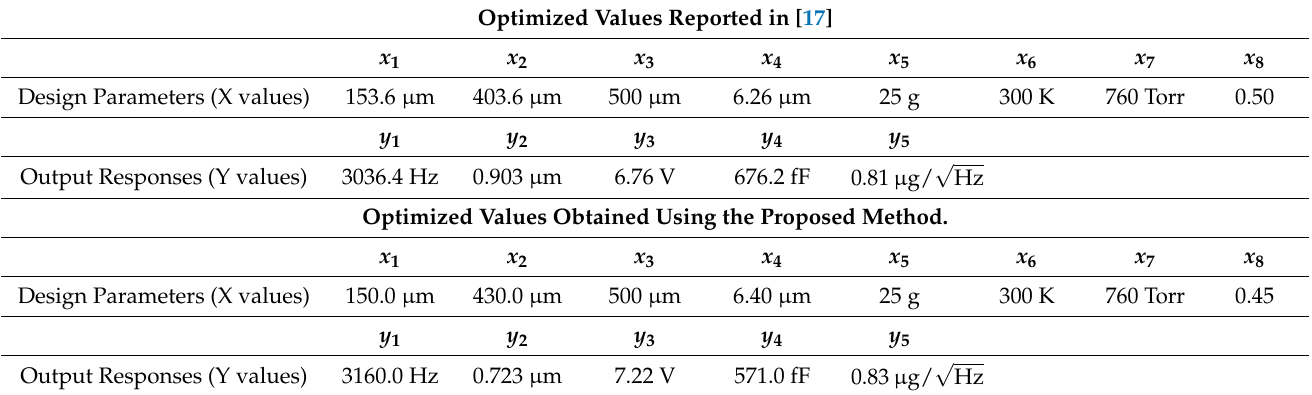
Table 3. Comparison of the obtained optimized X values (x 1 , x 2 , . . . , x 8 ) using the proposed method with those reported in [17]. The corresponding Y values (y 1 , y 2 , . . . , y 5 ) are also